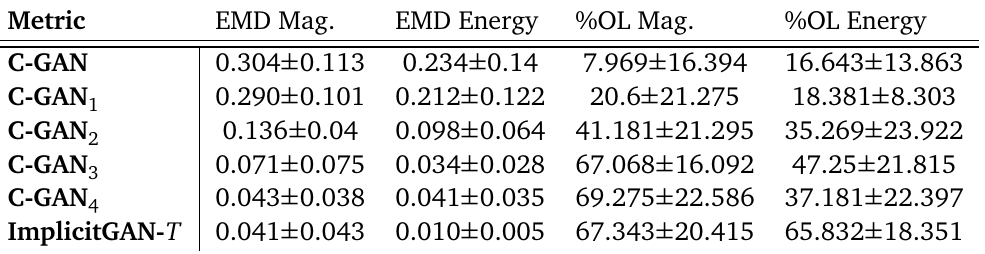
Table 2: Ablation analysis: Evaluation metrics, along with standard deviation, com- puted over 500 configurations of a 16 × 16 lattice, averaged across all temperatures. Smaller EMD and higher %OL are